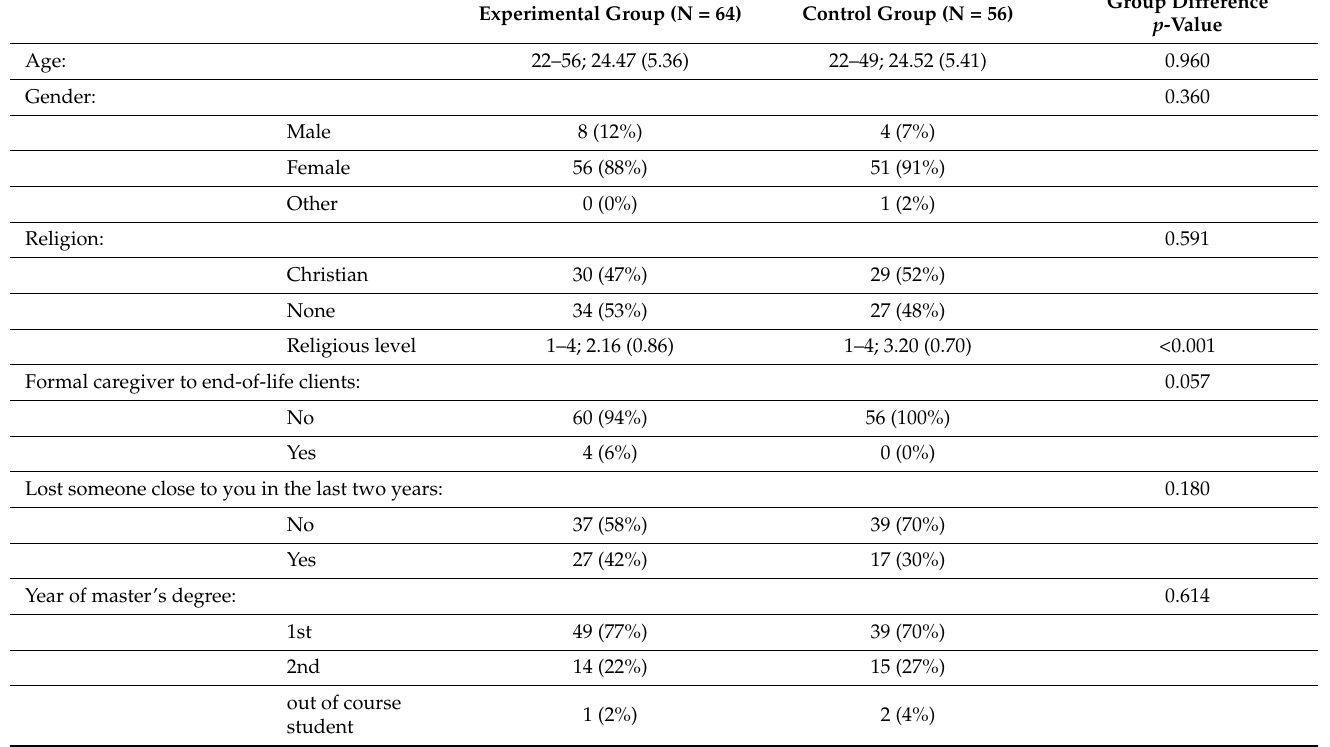
Table 1. Descriptive Statistics for Demographic Variables by Group 1